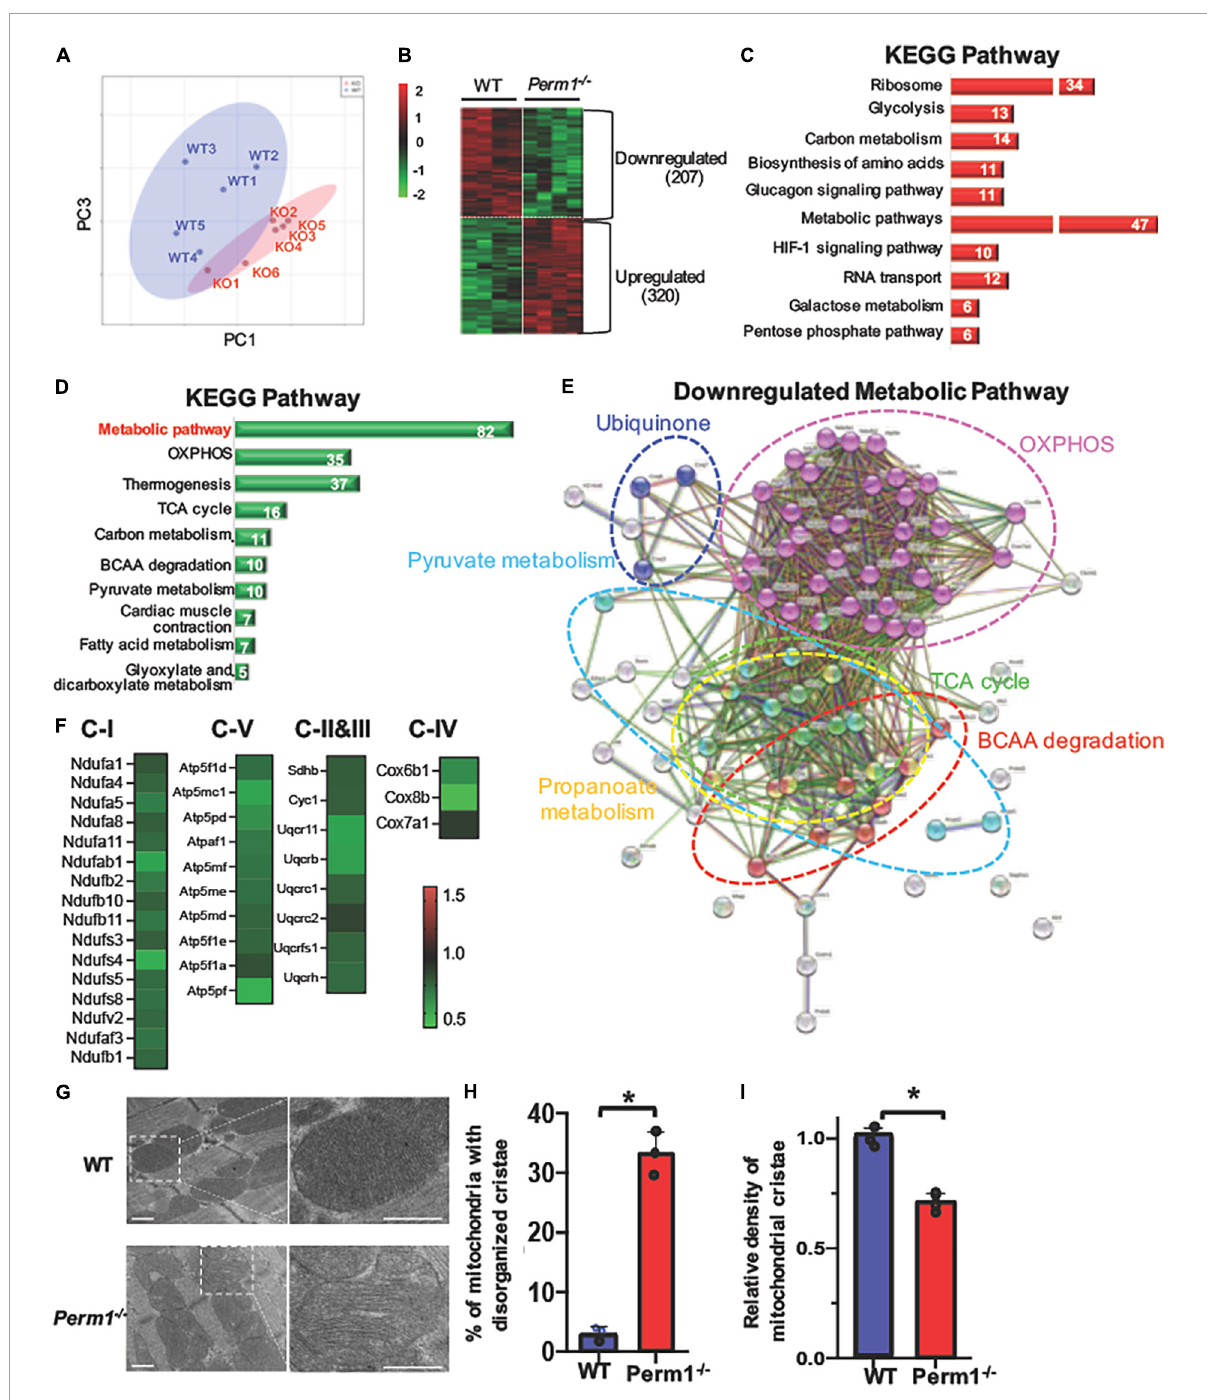
FIGURE3 Proteomic analysis of left ventricle tissue from Perm1 − / − mice and WT mice ( n = 5/group). Among 2,868 detected proteins, 207 proteins were significantly downregulated and 320 proteins were significantly upregulated in Perm1 − / − hearts ( p < 0.05 by t -test). (A) PCA of all detected proteins from Perm1 − / − ( red ) and WT hearts ( blue ). (B) Heat map of the proteins that were differentially expressed in Perm1 − / − heart. Enrichment analyses of upregulate (C) and downregulated proteins (D) for KEGG pathways. The white numbers in bar graphs indicate the number of proteins that were detected in each pathway. (E) Network map of the 82 significantly changed proteins which belong to the collective KEGG term metabolic pathways in panel (D) . (F) Heat maps of fold changes from the 35 proteins comprising the network map presented in panel (E) . Analysis of cardiac ultrastructure with representative electron microscopy images (G) , quantification of changes in mitochondrial cristae morphology (H) , and quantification of mitochondrial cristae density (I) of hearts of WT mice (blue bars, n = 3) and Perm1 − / − mice (red bars, n = 3). * p < 0.05 (student’s t -test), ±